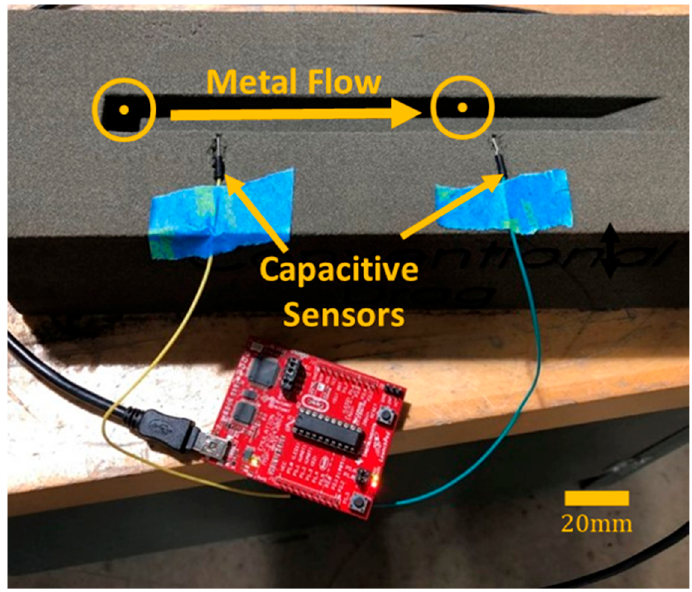
Figure 5. Capacitive filament sensors placed in the proximity of runner of SSC.